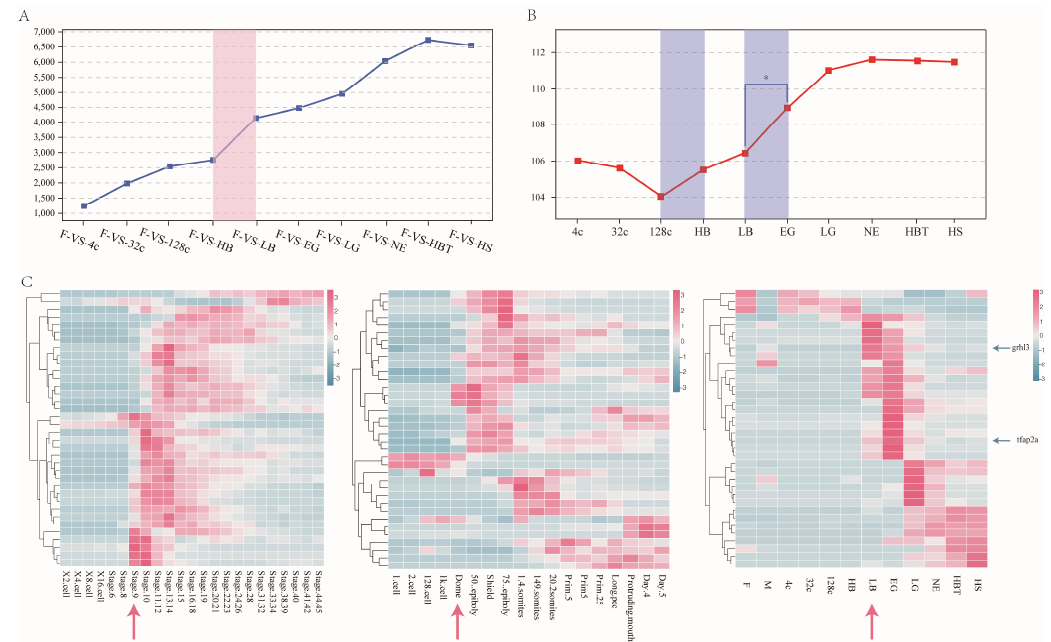
Figure 4. The transcription of zygotic genes during the embryonic stages. ( A ) The number of up-regulation DEGs compare zygote stage (each embryo development stage) with egg. ( B ) The average gene expression level of zygotic genes (remove maternal genes) during embryo development. * p < 0.05 means a statistically significant difference. ( C ) The 36 zygotic gene expression patterns during embryonic development of Xenopus , zebrafish and Japanese flounder. The arrow refers to the activation period of the ZGA. stage9: blastula stage, Dome: blastula stage, M: sperm, F: egg, 4c: 4-cell, 32c: 32-cell, 128c: 128-cell, HB: high blastula, LB: low blastula, EG: early gastrula, LG: late gastrula, NE: neurula, HBT: heart-beating, HS: hatching stage.